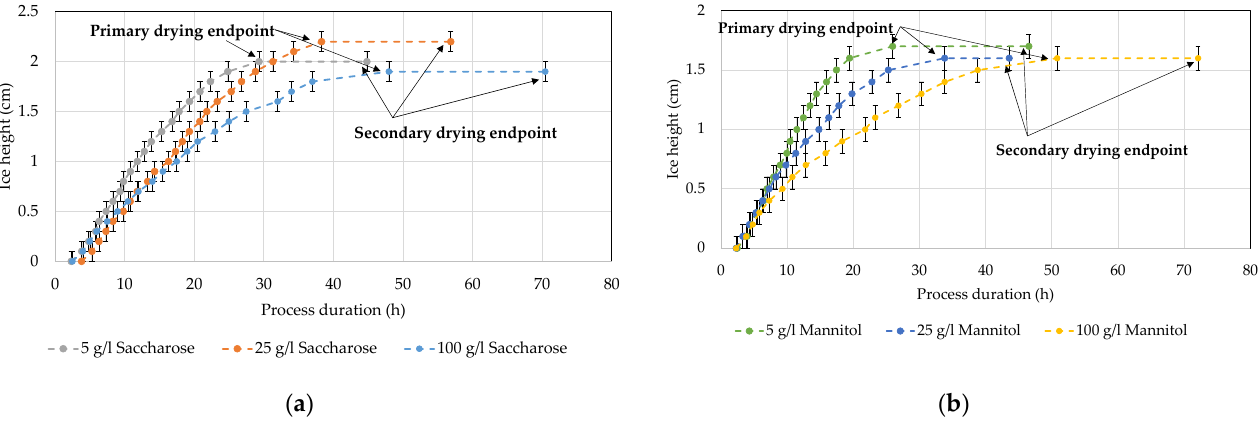
Figure 21. Ice height over time measured by an ice ruler for different solute concentrations of ( a ) saccharose and ( b )